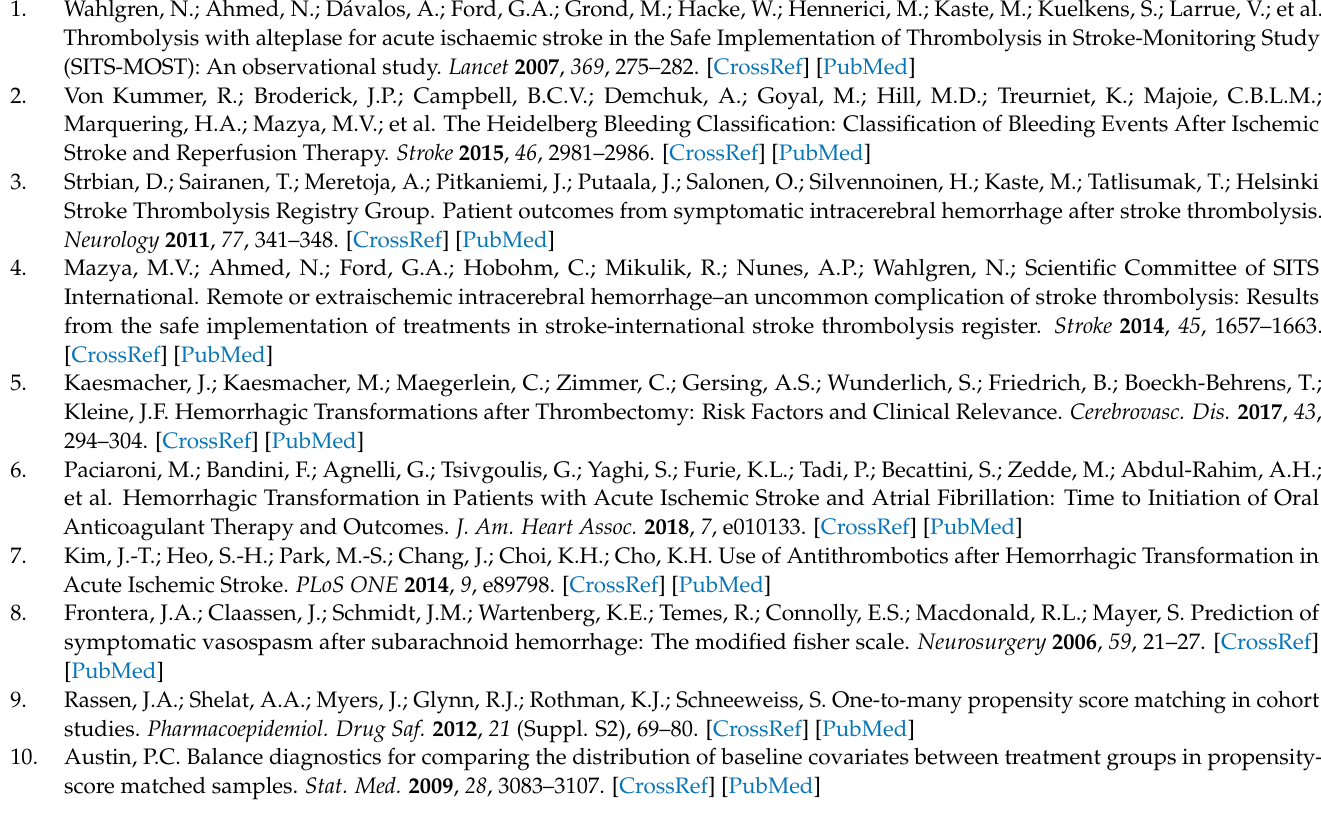
Table S3: Patients’ baseline characteristics at each center; Supplementary Table S4: Differences between unmatched patients with no hemorrhage, minor HT and major